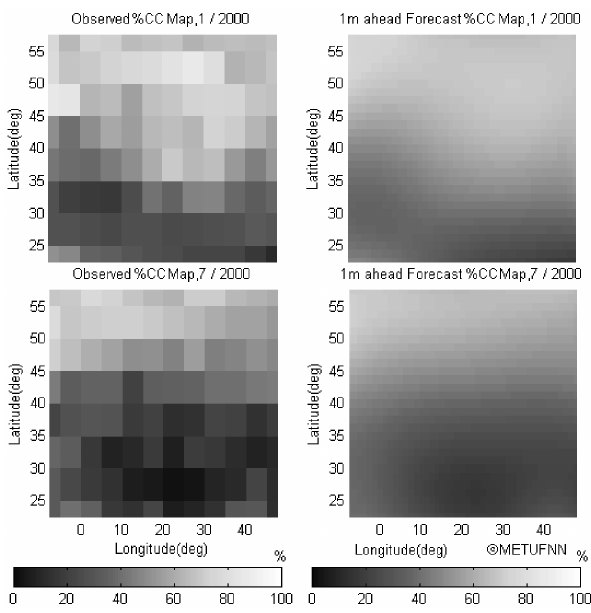
Fig. 5. Observed and 1 month ahead Forecast CTT maps of January and July